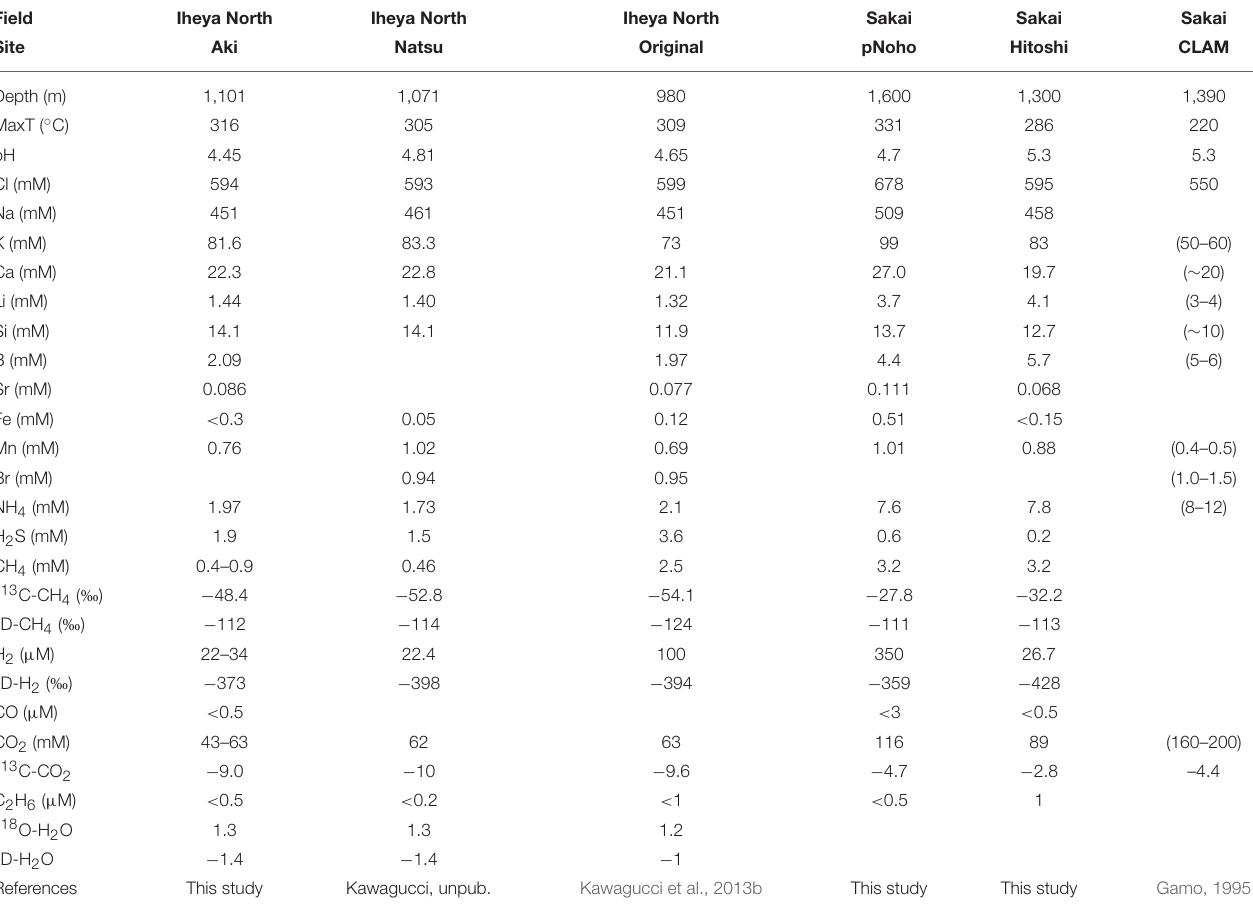
TABLE 3 | Endmember fluid chemistry of Iheya North and Sakai fields.